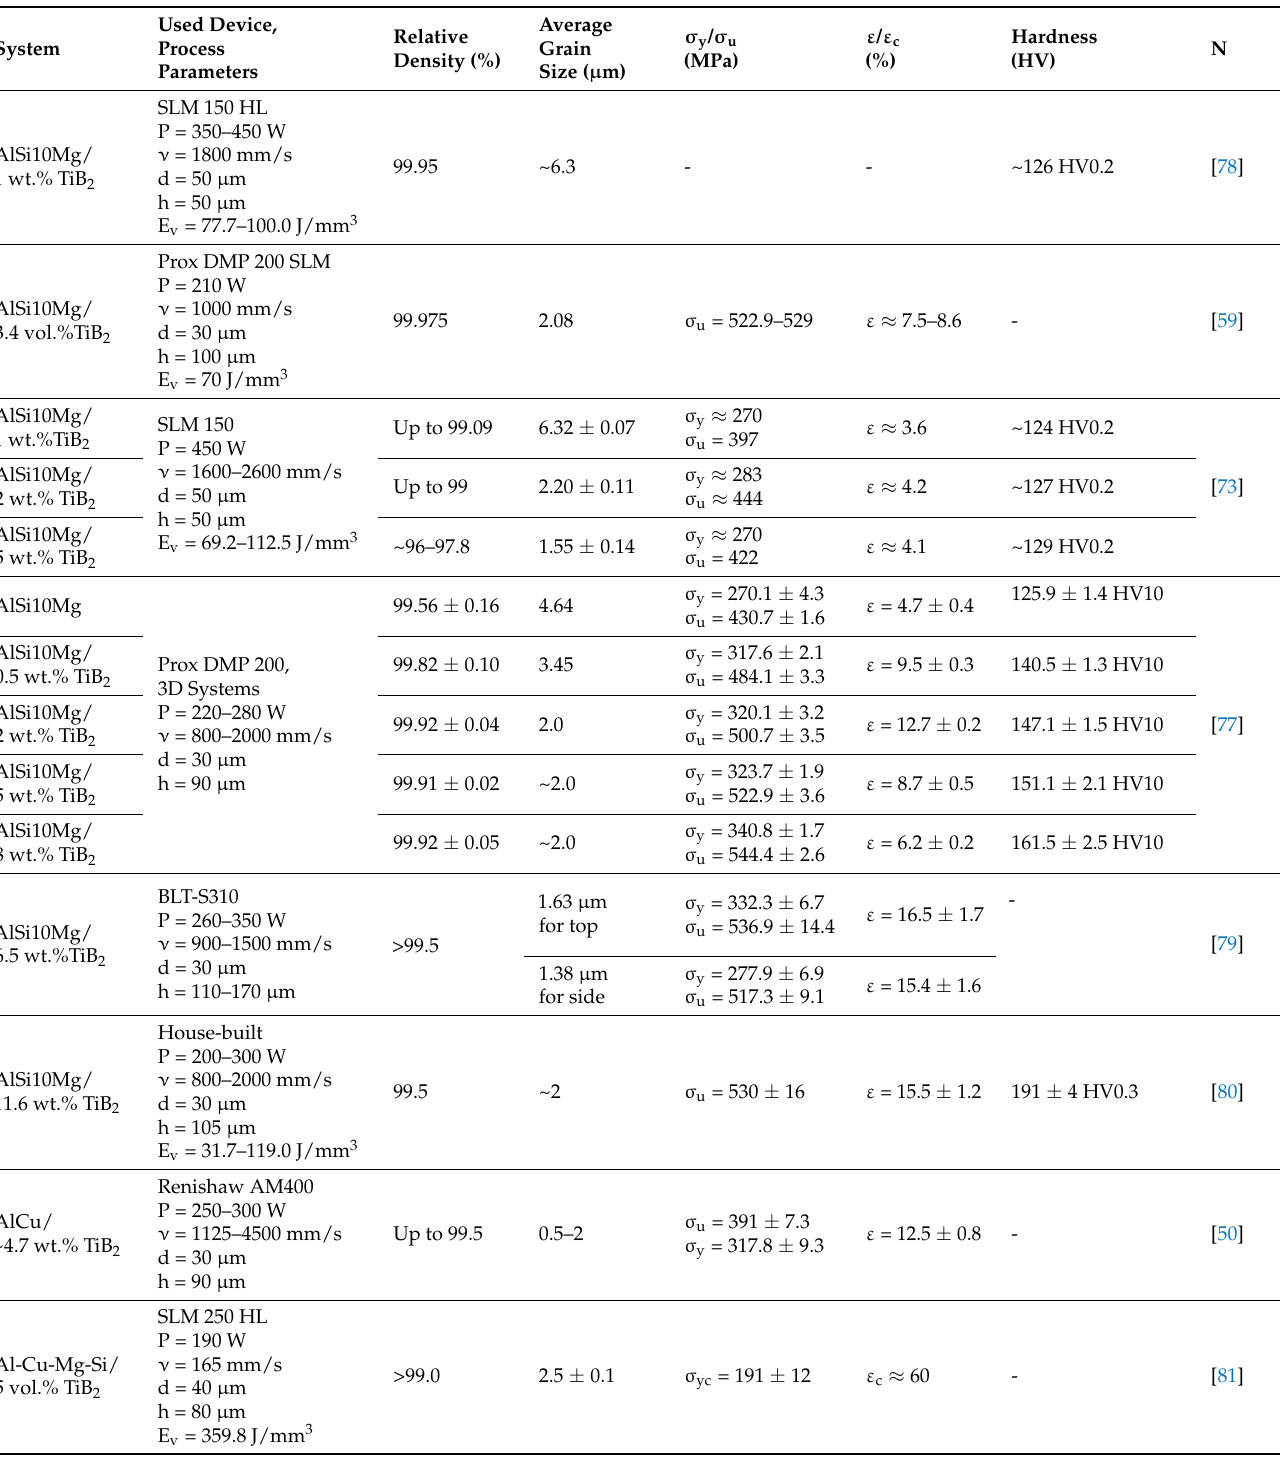
Table 1. Characteristics of boride (particulate) reinforced AMCs fabricated by laser powder-bed